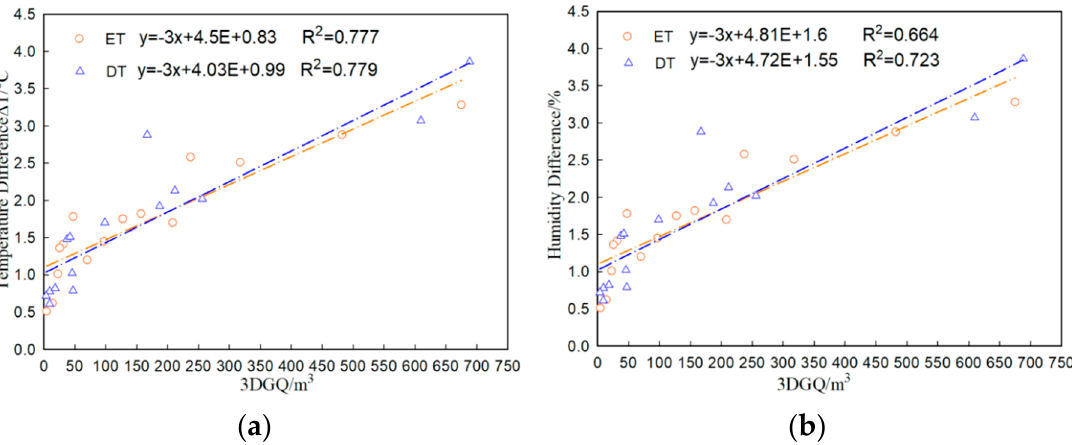
Figure 9. Correlation and fitting function model of 3DGQ of ET and DT. ( a ) 3DGQ and cooling effect; ( b ) 3DGQ and humidifying effect. ET: evergreen tree species; DT: deciduous tree species; 3DGQ: three dimensional green quantity.